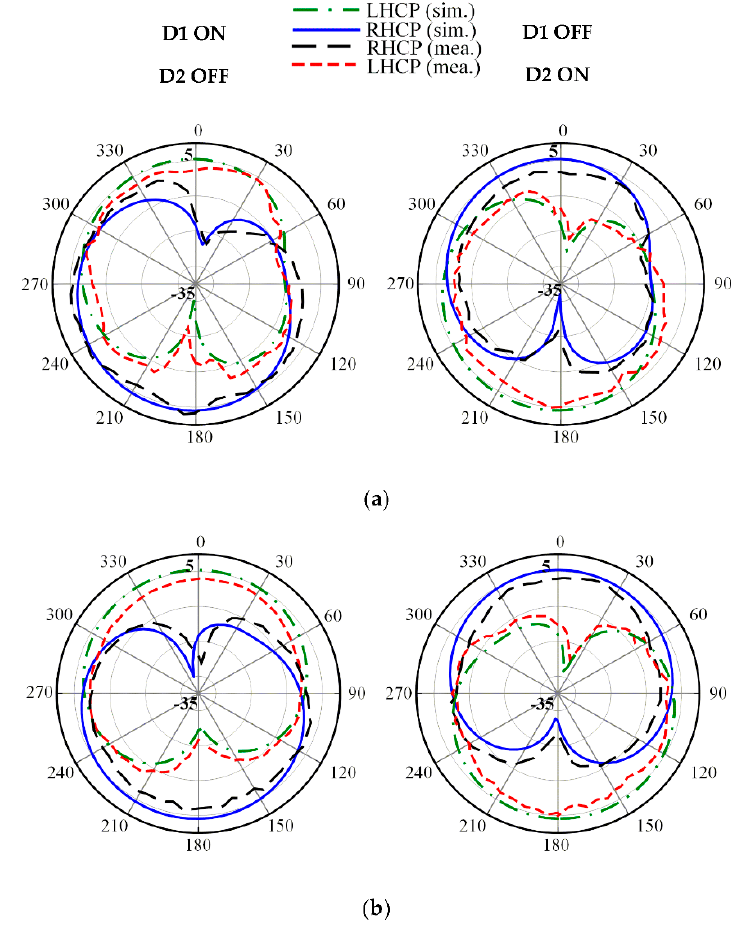
Figure 12. Measured radiation patterns at 2.5 GHz on: ( a ) x - z plane; ( b ) y - z plane.